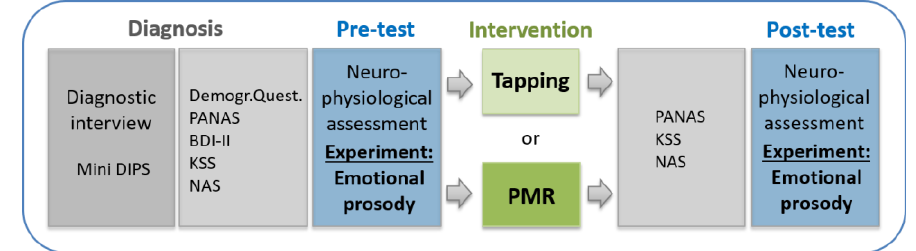
Figure 3. Experimental procedure including behavioral measures. Progressive Muscle Relaxation (PMR), Positive and Negative Affect Schedule (PANAS), Beck Depression Inventory-II (BDI-II), Karolinska Sleepiness Scale (KSS), Numeric Analogue Scale (NAS), Diagnostisches Kurz-Interview bei psychischen Störungen (Mini-DIPS).